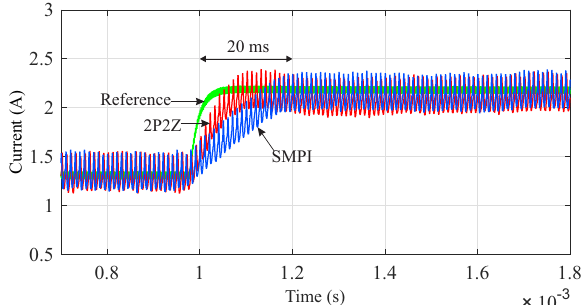
Figure 11. Comparison of the SMPI and 2p2z controllers for a current step test.